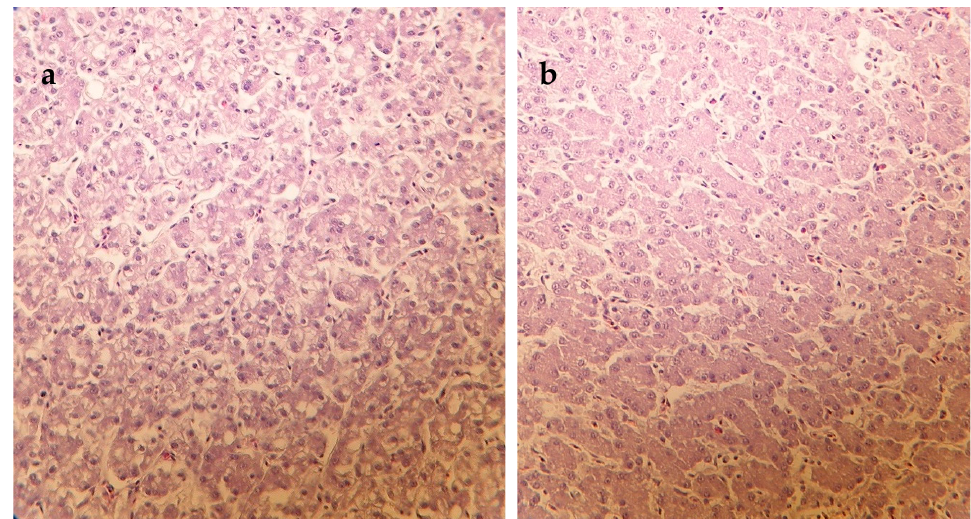
Figure 1. Hematoxylin and eosin-stained sections of duck’s livers ( a ) Liver section of a duck fed mycotoxin-contaminated control diet showing medium grade vacuolization of hepatocytes (day 14), 400 × magnification; ( b ) Liver section of a duck fed mycotoxin contaminated diet supplemented with milk thistle seed showing healthy hepatocytes (day 14), 400 ×